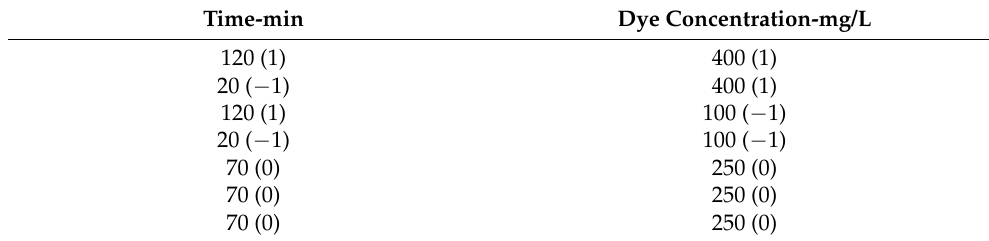
Table 1. Experimental design of dye adsorption